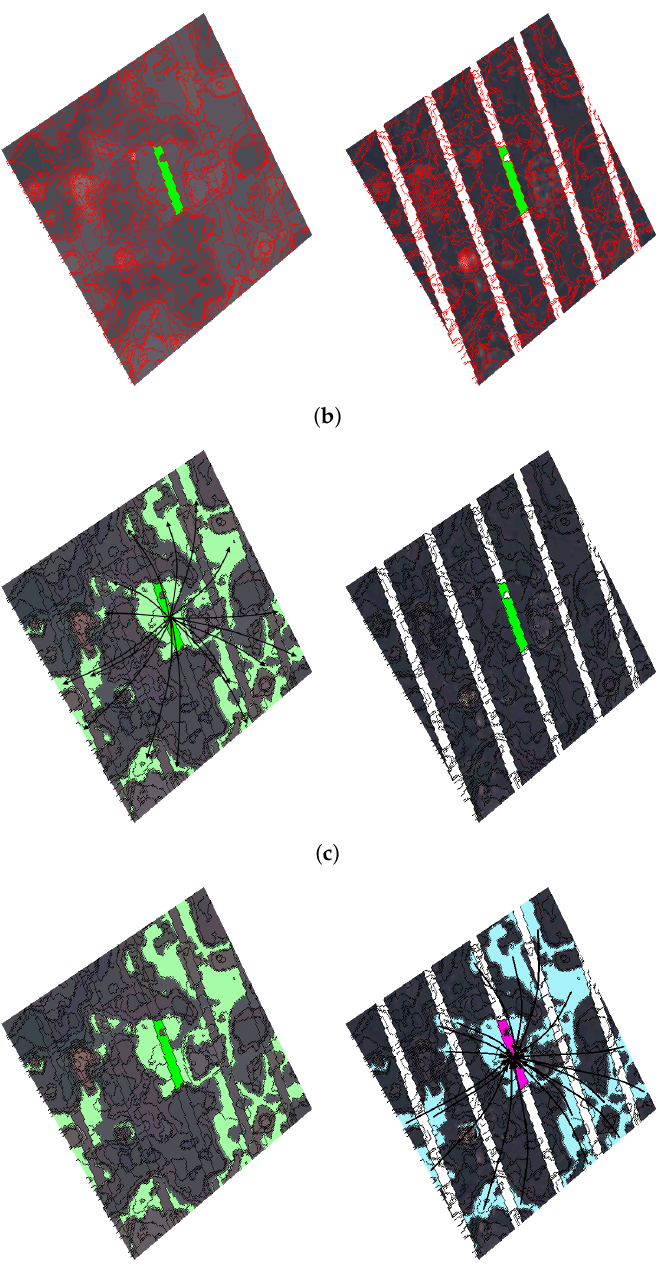
Figure 18. Scheme for the construction of radiometric data set for reconstruction. ( a ) base and target images; ( b ) base and target images with red region boundaries and one region in green; ( c ) base and target images with red region boundaries and one region in green and with base coherent regions in light green; ( d ) base and target images with red region boundaries and one region in green, base coherent regions in light green and with target coherent regions in light